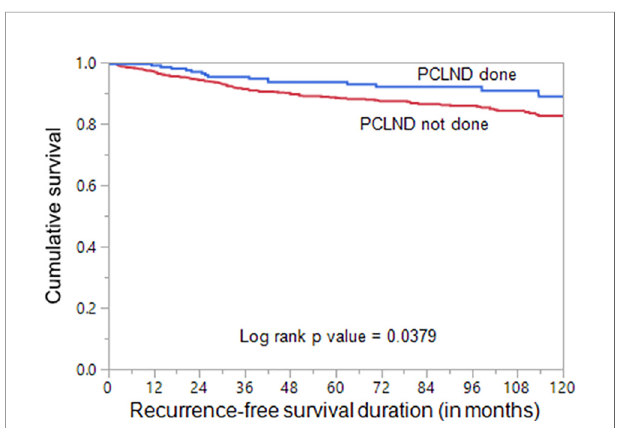
FIGURE 1 | Recurrence-free survival analysis of prophylactic central lymph node dissection (PCLND) in clinically node negative (cN0) PTC. Kaplan Meier survival plot showing statistically signi fi cant improved recurrence-free survival in patients undergoing PCLND compared to those that did not (p = 0.0379).